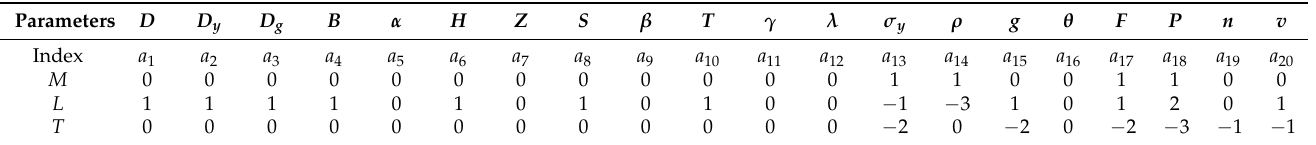
Table 1. Dimensional matrix of spiral drum design